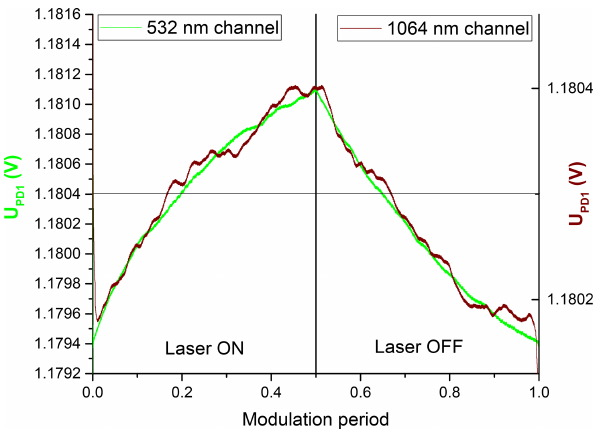
Figure 4. Instrument response S (lock-in amplifier signal at the op- timum phase) at different durations of the modulation period. The responses are normalized to the response at 167ms. The error bars designate a standard deviation of 1s